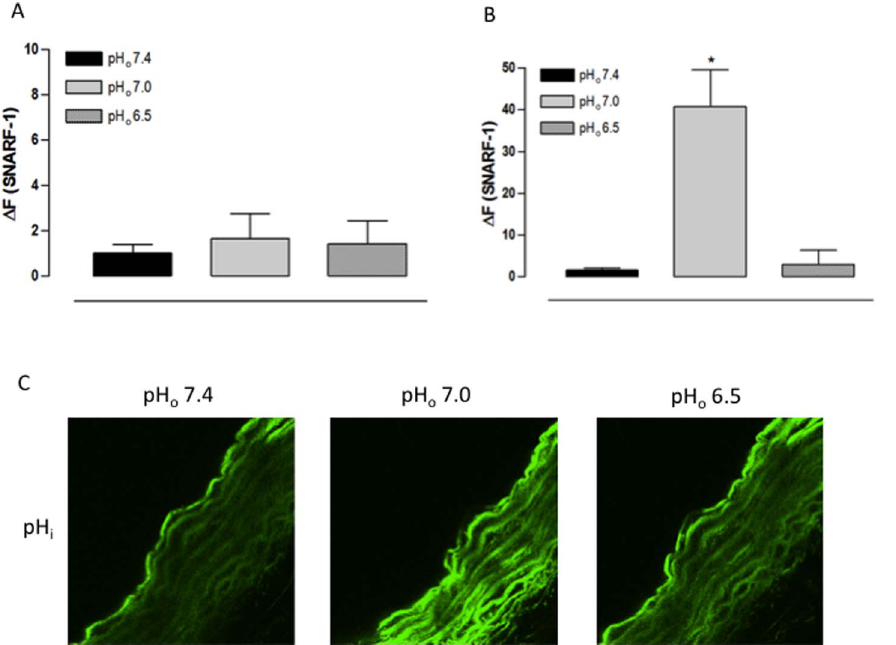
Figure 5. Effect of extracellular acidification on pH i of rat aorta cross sections assessed using a confocal scanning laser microscope. A) Fluorescence intensity for endothelial layer. B) Fluorescence intensity for muscular layer. C) Representative confocal photomicrograph of one aorta cross section. Aorta cross sections were loaded with SNARF-1 (10 m M) and analyzed by confocal microscopy. Aorta cross sections were stimulated at 3 rd and 9 th min with Hanks acidified solution pH 7.0 and 6.5, respectively. HCl was used to change the pH of Hanks solution; Hanks solution pH 7.4 served as control. Fluorescence intensity was measured before the stimulus (F) and at 6 th min after the stimulus for each pH o value (F pH ). Results are reported as D F=F pH – F. All values are means 6 SEM (n=7). One-way ANOVA, Bonferroni’s post-test, * p , 0.01 versus